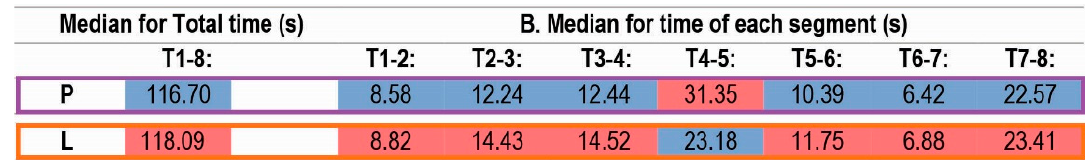
Figure 7. Comparison of the median time for landscape and portrait orientation.